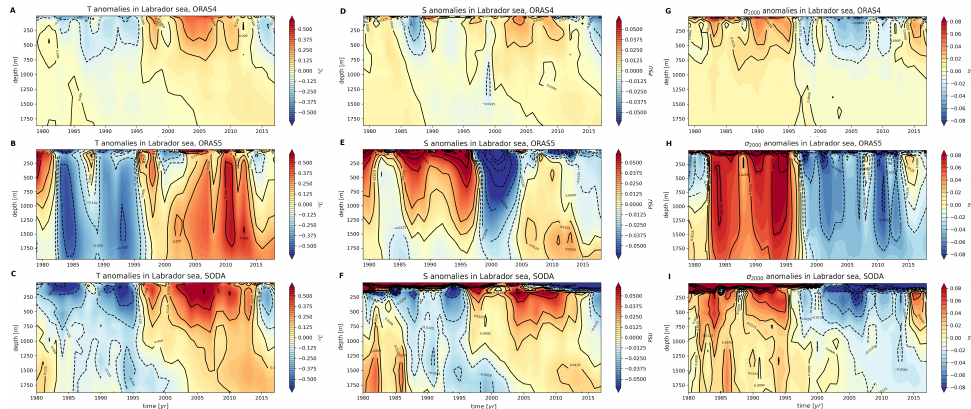
Figure A3. Comparison between ORAS4, ORAS5, and SODA in the Labrador Sea: Temperature anomalies in ( A – C ), salinity anomalies in ( D – F ), and σ 2000 in ( G – I